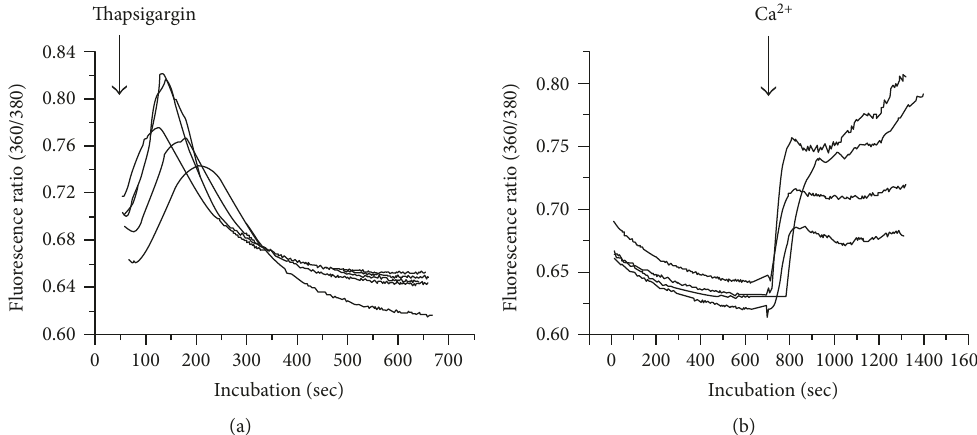
Figure 3: E ff ects of thapsigargin on cytosolic calcium (a) and calcium addition to store-depleted di ff erentiating stem cells (b). Cells were incubated in a calcium-free medium with 10 μ M EGTA and then 2 μ M thapsigargin was added (arrow). The cells were dye loaded in Krebs-Ringer solution (containing 2mM calcium). The results from fi ve independent experiments are shown, each represents the mean value from 29 to 65 cells, all of which with a calcium transient in response to thapsigargin (a). The cells were dye loaded in the presence of calcium and thapsigargin (2 μ M). The dye was removed and the cells were primed with 2 μ M thapsigargin for 12min in calcium-free solution. Then 2 mM calcium was added, and the incubation lasted for 8 – 11 min. The results from four independent experiments are shown, each representing the mean value obtained from analysis of 23 to 39 cells, all of which displayed calcium transients in response to the addition of calcium